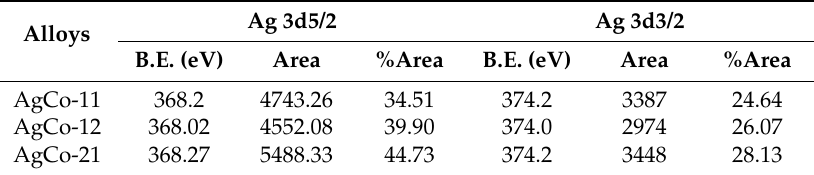
Figure 7. XPS spectrum of Ag 3d in Ag-Co: ( a ) peak intensity spectrum of Ag 3d; ( b – d ) deconvoluted spectrum of each Ag 3d. Table 1. Measured XPS spectrum for Ag 3d and the quantitative